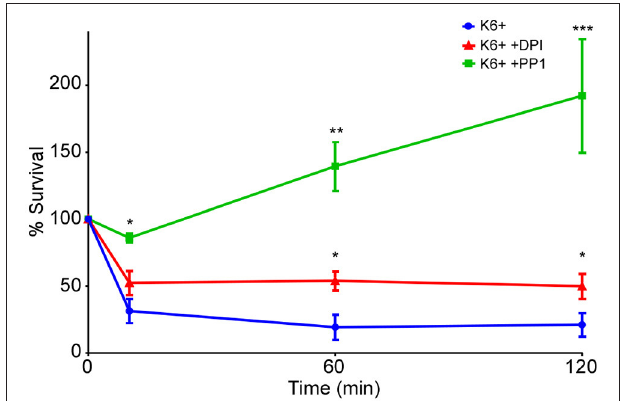
the NADPH oxidase inhibitor DPI (10 µ M) or the Src kinase inhibitor PP1 (30 µ M) 30min prior to infection with Y. pestis KIM6 + . Cells were lysed, triturated and plated to enumerate CFU at 10, 60, and 120min post-infection. Each graph represents the mean of 3 independent experiments. Error bars represent SEM. Statistical differences were determined by multiple t -tests comparing 2 groups at each time point, corrected for multiple comparisons using Holm-Sidak method. * p < 0.05, ** < 0.01, *** <